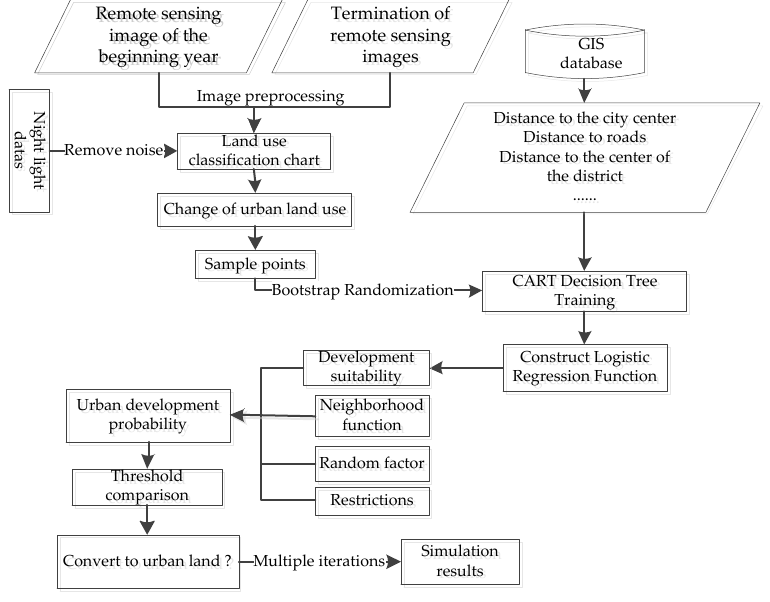
Figure 7. The CA model flowchart.